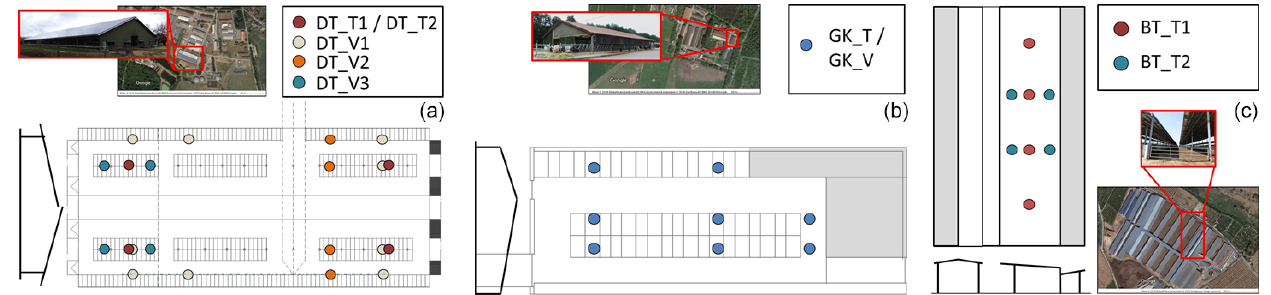
Figure 1. Outer view of the reference barn (source: ATB), aerial photo of the associated farm (source: Google Maps, © 2018 DigitalGlobe; panels a and b : GeoBasis-DE/BKG, GeoContent, Kartendaten, © 2018 GeoBasis-DE/BKG (© 2009), © Google; panel c : Kartendaten © 2018 Google, Inst. Geogr. Nacional) and distribution of the sensor positions during different measurement campaigns for the three reference barns in Dummerstorf (a) , Groß Kreutz (b) and Bétera (c) . In addition, the roof shapes are sketched. Details on the measurement campaigns can be found in Table. 1 (cf. IDs). Table 1. Overview of on-farm measurement campaigns. Measurements were conducted approximately 3m above the floor of the barns. The horizontal distribution of measurement points is sketched in Fig. 1 (cf. IDs). Device specifications: Comark Diligence EV N2003 sensors (Comark Limited, Hertfordshire, UK) logged temperature and relative humidity every 10min (instantaneous value for the second). EasyLog USB 2+ sensors (Lascar Electronics Inc., USA) logged temperature and relative humidity every 5min (instantaneous value, shortest logging rate 10s). Three-axis ultrasonic anemometers of the Wind Master type (Gill Instruments Limited, Hampshire, UK) logged air velocity every second. Begin and end of the measurement periods are provided in the format dd-mm-yyyy. Focus region Reference barn Begin End Devices ID Central European maritime